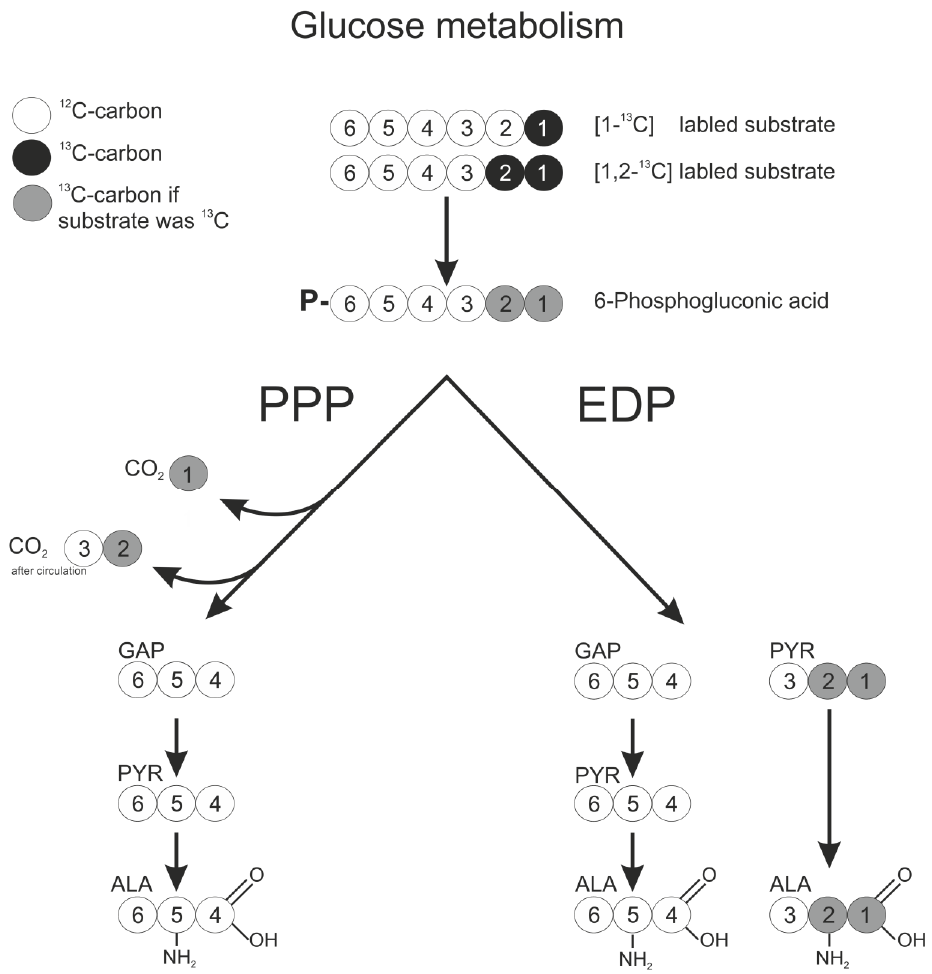
Figure 2. Transition scheme of glucose via the pentose phosphate pathway (PPP) and the Entner–Doudoroff pathway (EDP). The circles indicate carbon atoms in the isotopic states 12 C (white) and 13 C (black); depending on the substrate, the products may contain the 13 C labeling (grey). The numbers of the carbon position in glucose is based on IUPAC